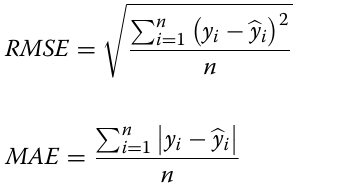
(cid:31) is seen in Fig. 2 as plots of the A visualization related to (cid:31) f ps values against the linear model’s predicted values, (cid:31) 2 2 While R , R values closer to 1 indicate better fitting a , and models, RMSE and MAE are best minimized. RMSE gives greater emphasis on extreme values, whereas MAE treats all data points with equal